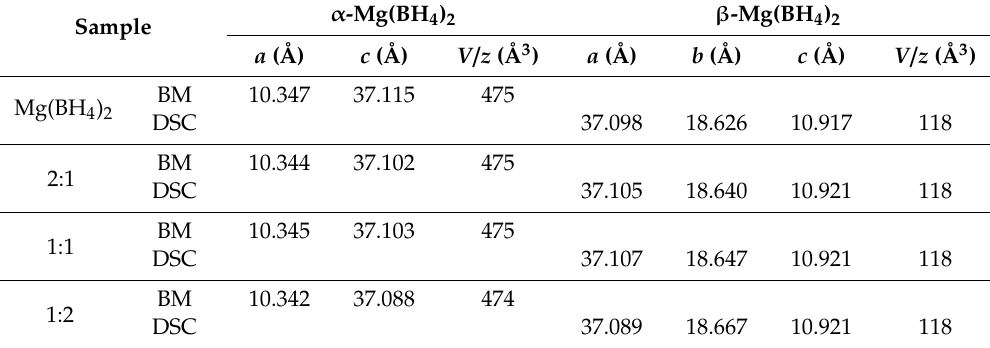
Table 2. Cell parameters ( a , c ) and volumes per formula unit ( V / z ) obtained from Rietveld refinement of α (z = 30) and β (z = 64) phases of Mg(BH 4 ) 2 after BM and DSC cycling under 2 bar of H 2 for pure Mg(BH 4 ) 2 and mixtures (2:1, 1:1, 1:2 molar ratio Mg(BH 4 ) 2 :Ca(BH 4 ) 2 ). After BM, only the α phase was present, while after DSC cycling under 2 bar of H 2 only the β phase was observed.